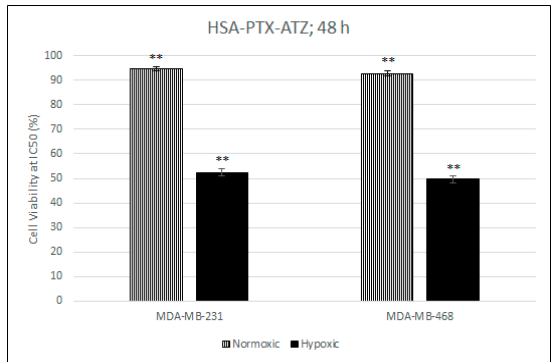
Figure 5. Comparative in vitro cytotoxicity studies for normoxic and hypoxic conditions in MDA-MB- 231 and MDA-MB-468 cell lines respectively for the hypoxia targeting drug delivery system HSA- PTX-ATZ. ** Statistically significant.